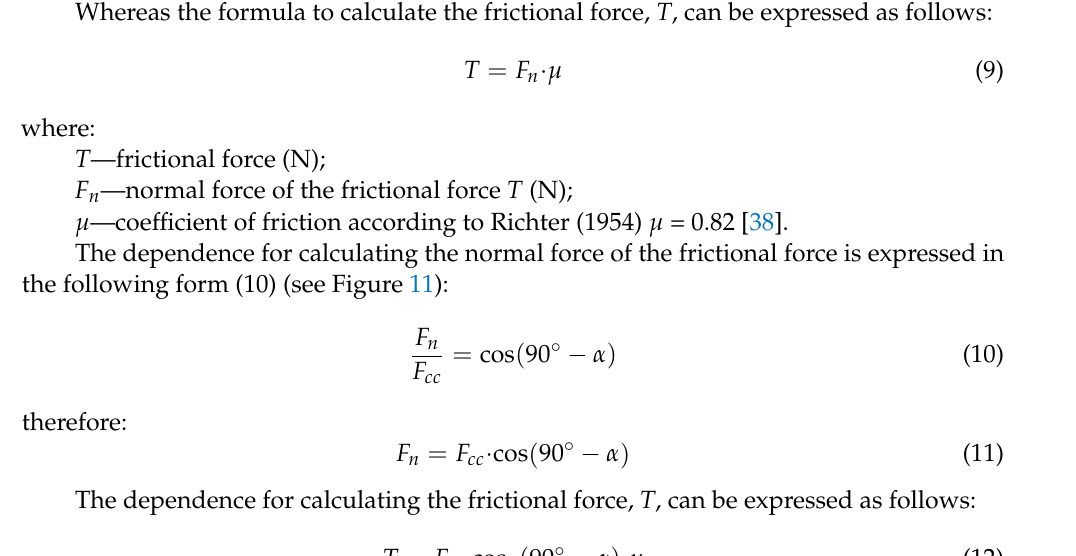
Figure 11. The analyzed distribution of forces on the knife blade, where: F cc —corrected value of the measured cutting force (N), T —frictional force (N), T y —vertical frictional force component (N), T x —horizontal frictional force component (N), F n —normal force of the frictional force (N), α —blade angle (°).